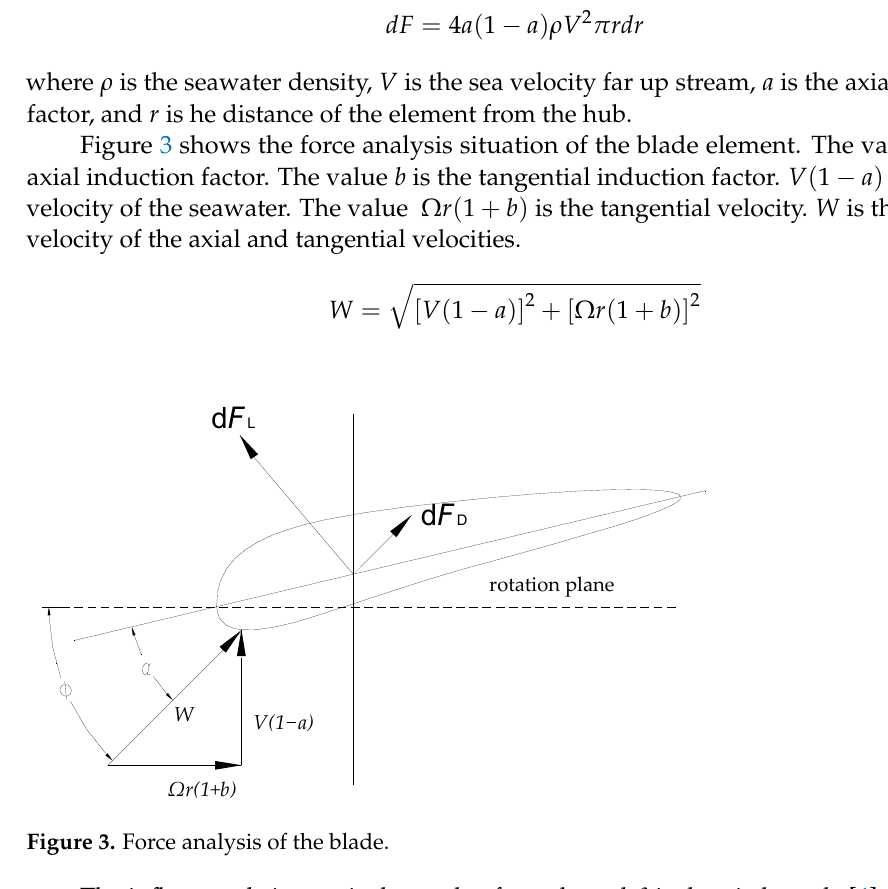
Figure 3. Force analysis of the blade.